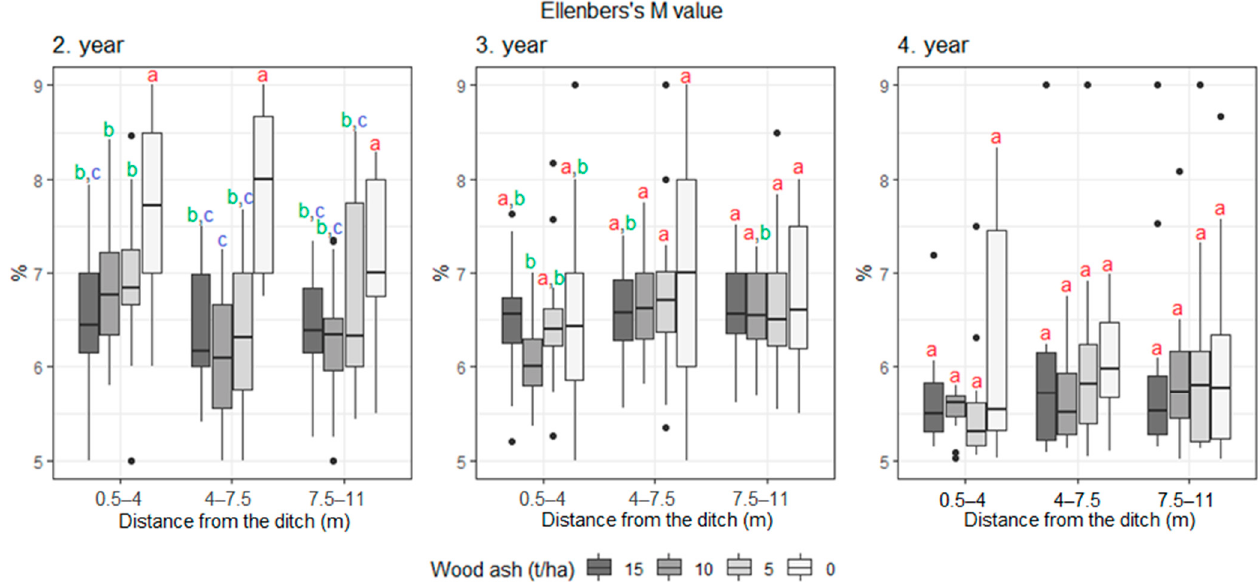
Figure A9. Relative of plants with ruderal universal adaptive strategy from the total vegetation cover, depending on the distance from the drainage ditch and the dose of wood-ash fertiliser. Different letters (a, b) indicate significant differences between groups, p < 0.05 according to the Tukey HSD test.